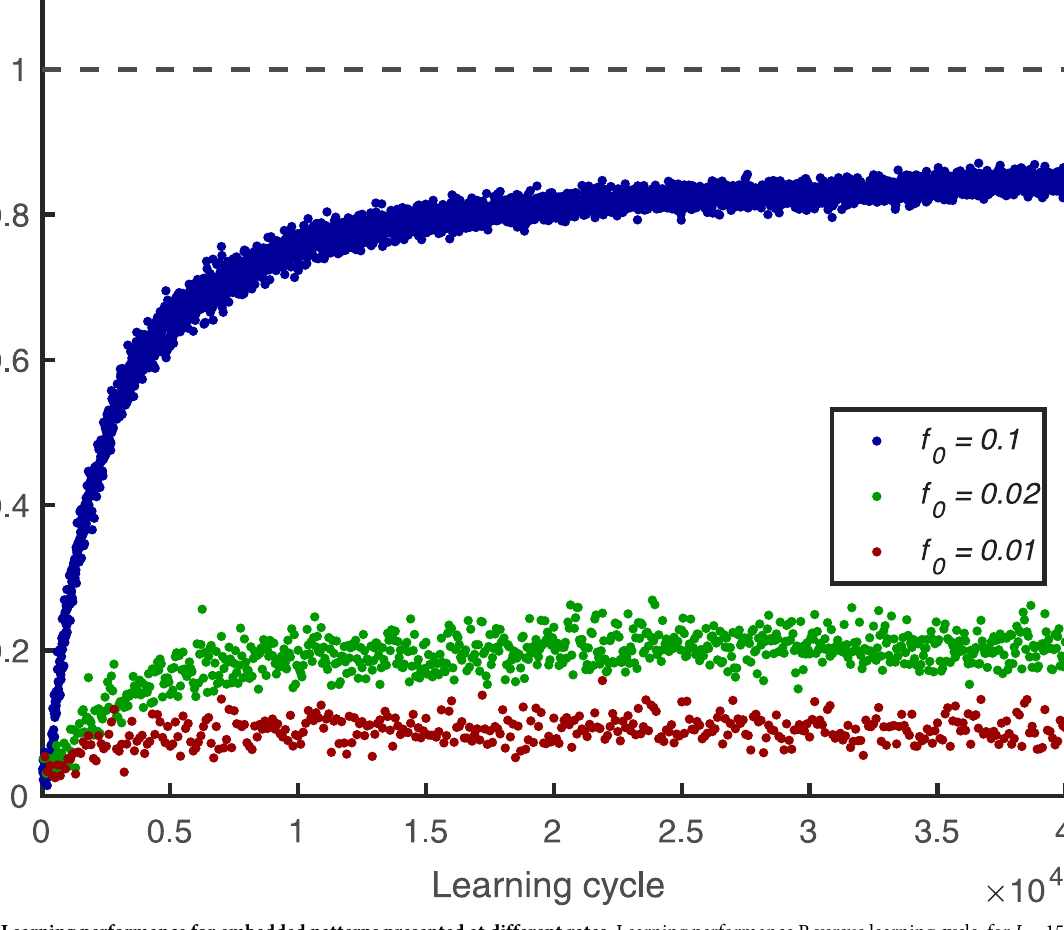
Fig 12. Learning performance for embedded patterns presented at different rates. Learning performance R versus learning cycle, for L = 15 ms. A 50 ms pattern is embedded between 500 and 550 ms and shown each 10 cycles ( f 0 = 0.1), 50 cycles ( f 0 = 0.02), and 100 cycles ( f 0 = 0.01). R is an average of 100 simulations, in which there are 500 afferents, and the length of the training epoch is 1000 ms. The desired firing rate is r 0 = 2